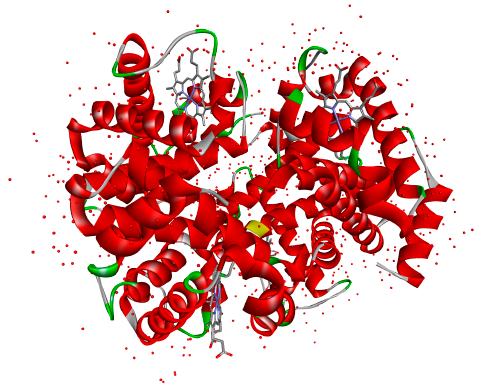
Figure 1. Ribbon diagram of Bovine Hemoglobin showing the position of the four hemes (blue) taken from the RCSB Protein Data Bank and plotted on BIOvia Discovery Studio Visualizer.